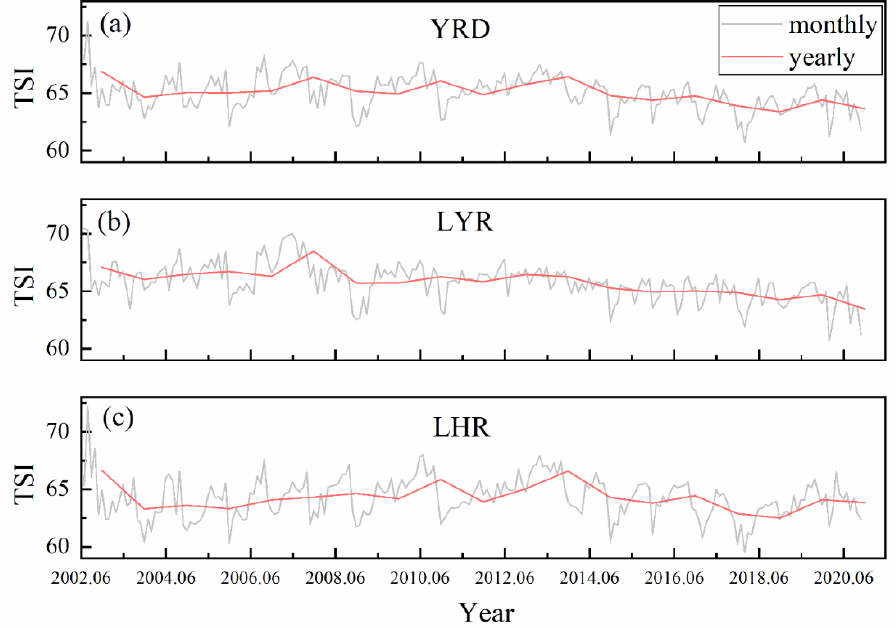
Figure 9. Annual and monthly changes in the TSI average from 2002 to 2020: ( a ) YRD, ( b ) LYR, and ( c ) LHR.